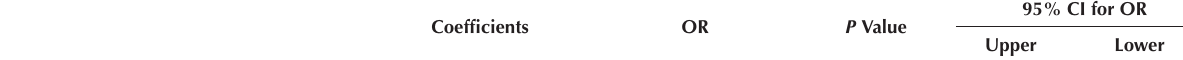
95% CI for OR Upper